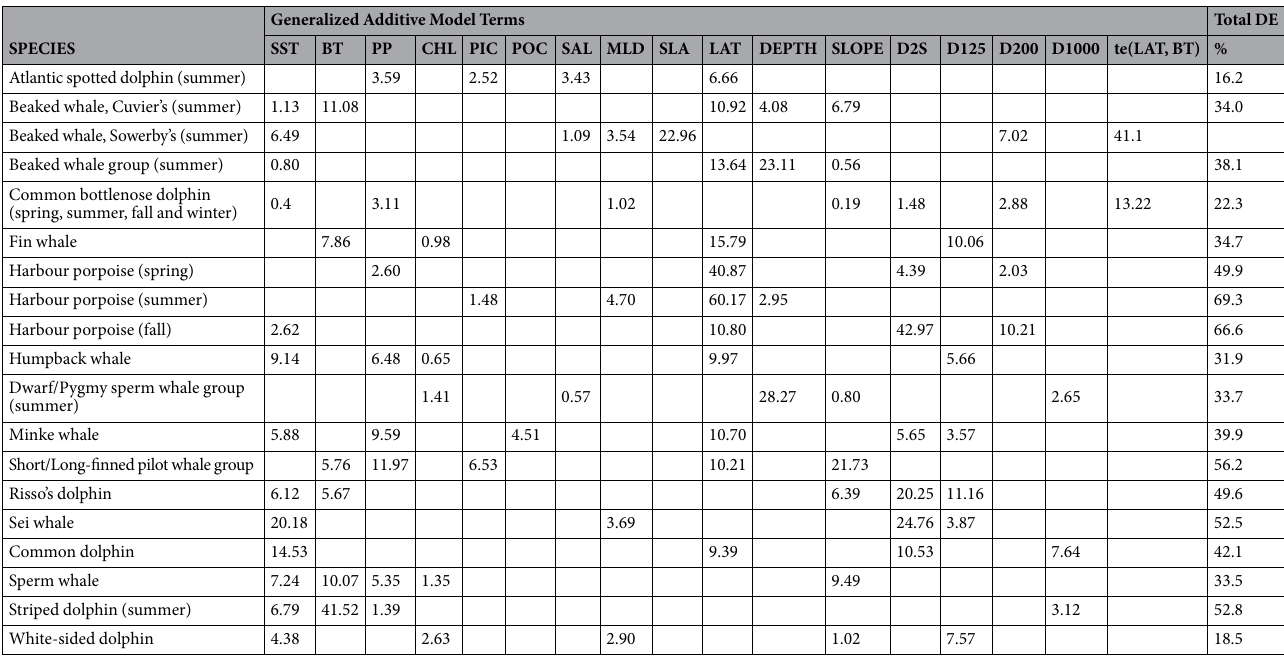
Table 1. Percent deviance explained (DE) by term for each species model. The data input for the models cover spring, summer and fall seasons unless is specified in parenthesis. All the model terms were significant at p < 0.05 by a Wald-type test of f = 0 54